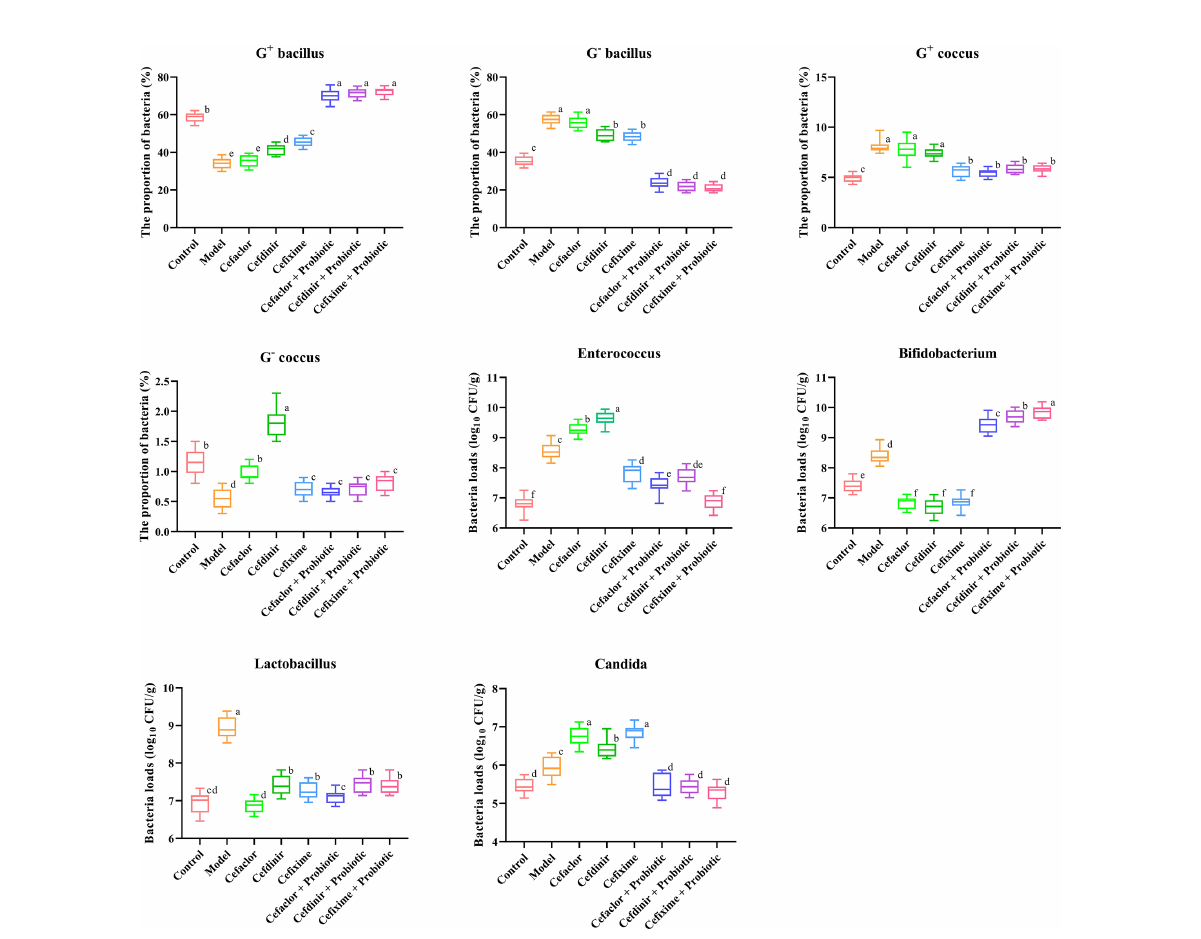
FIGURE 5 Effects of cephalosporins on the microbial proportions and compositions in the intestinal contents of Spn-infected mice. Data were showed as mean ± SD. Different letters indicated statistically signi fi cant differences, P